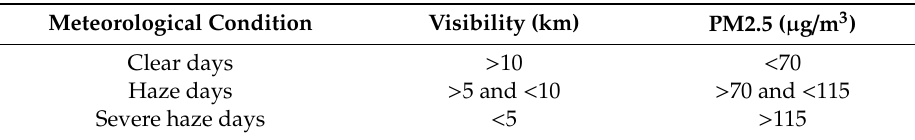
Table 2. Di ff erent meteorological